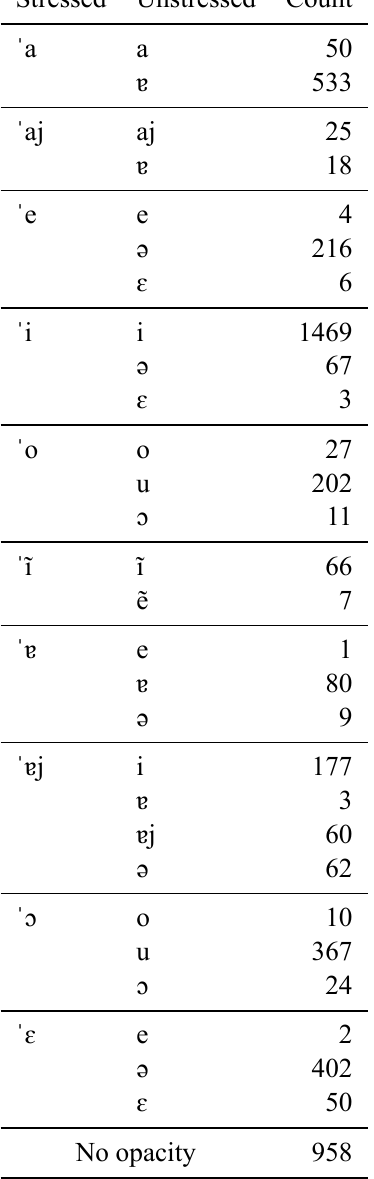
Table 22: Prediction of unstressed from stressed prethematic